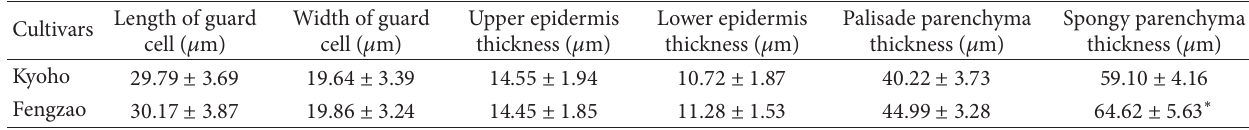
Table 2: Size of guard cell and stomata density among experimental varieties. Length of guard Cultivars cell ( 𝜇 m)